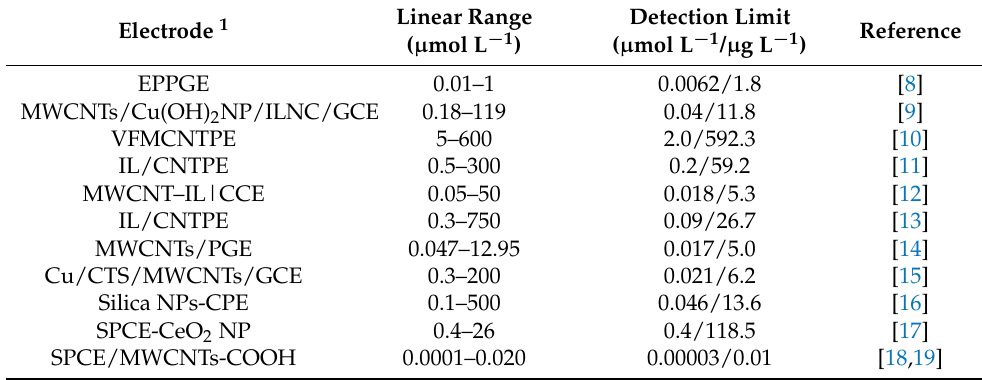
Table 1. Analytical performance of electrochemical methods previously developed for the quantifica- tion of diclofenac using carbon-based